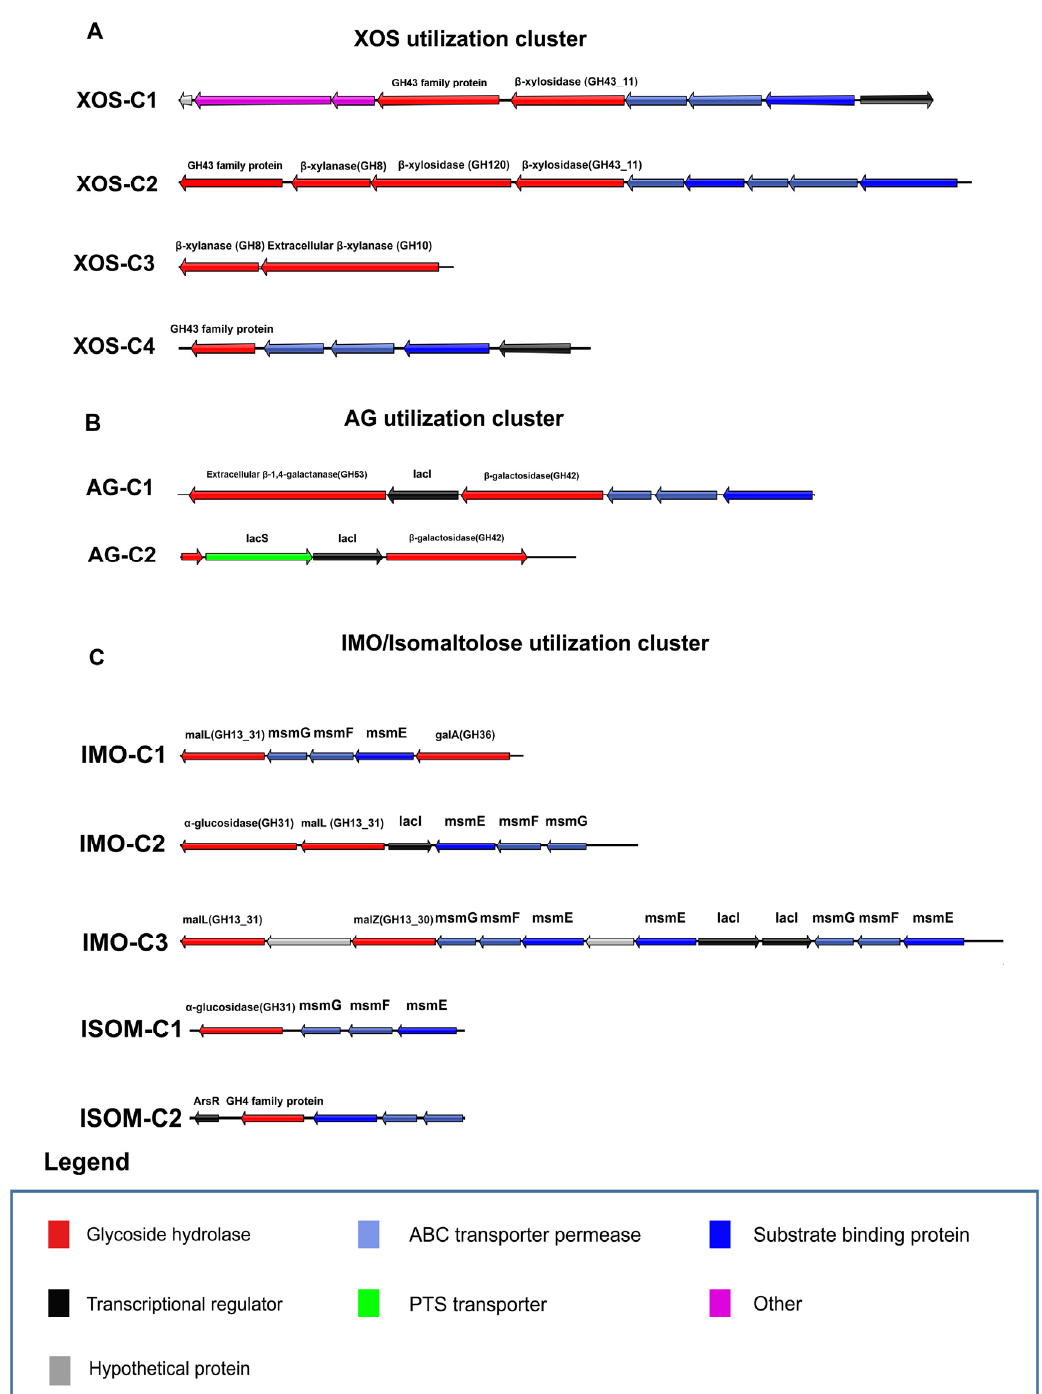
Figure 6. Locus map representing predicted carbohydrate utilization clusters. ( A ) XOS utilization clusters. ( B ) AG utilization clusters. ( C ) IMO/isomaltulose utilization clusters.